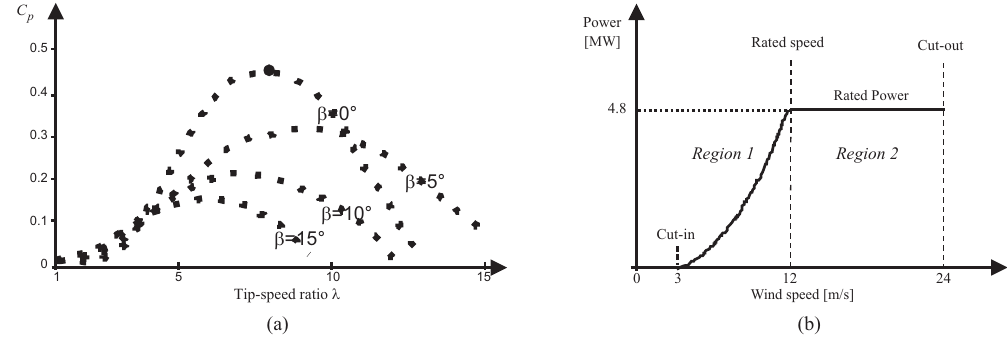
Figure 3. Examples of power coefficient function ( a ) and power curve ( b ).